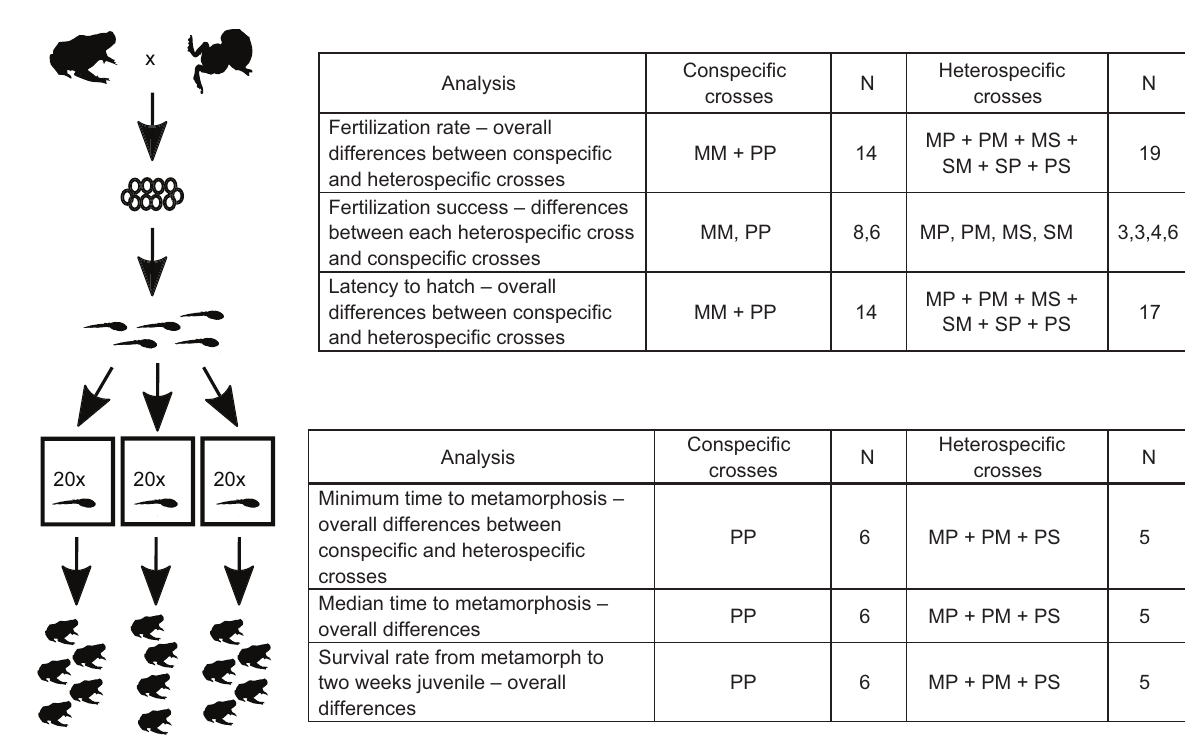
Fig 1. Rearing methodology and description of analyses. (A) Within 12 hours after mating, we transferred foam nests to a containerwith 5cm deep rainwater.On the 5 th day after the first tadpolehatched, we separatedtadpoles into three rearingtanks containing20 tadpoles each. (B) Table includingthe list of crosses used for each analysiswith sample size for each group. Single numbersrepresent the total numberof crosses for that group combination; numbersseparatedby a comma represent sample sizes for each cross type in the same order in which the cross types are